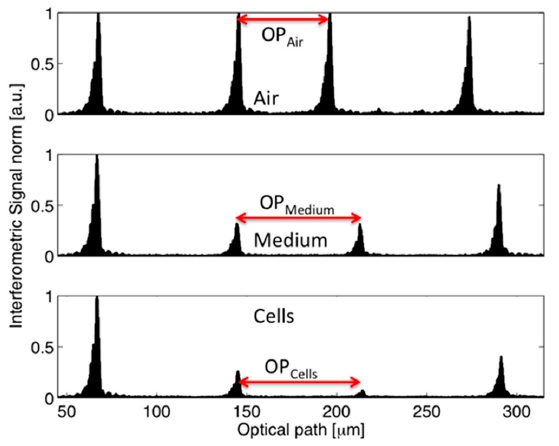
Figure 4. Normalized interferometric signal as a function of the optical path obtained on a 50- μ m-deep capillary in presence of air (upper trace), culture medium (middle trace) and cells (lower trace). OP Air : optical path length of the channel with air; OP Medium : optical path length of the channel filled with culture medium; OP Cells : optical path length of the channel filled with cells.